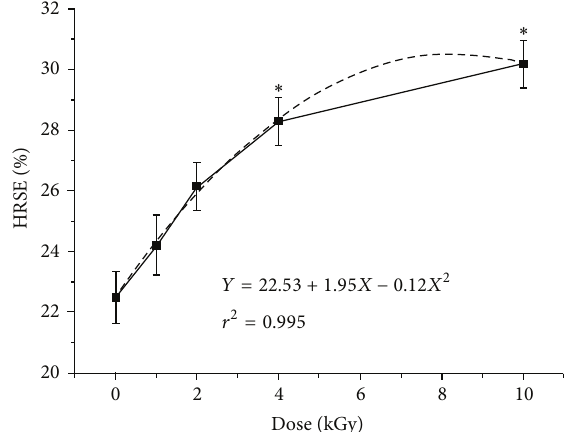
Figure 2: Effect of different doses of gamma irradiation on HRSE of soybean